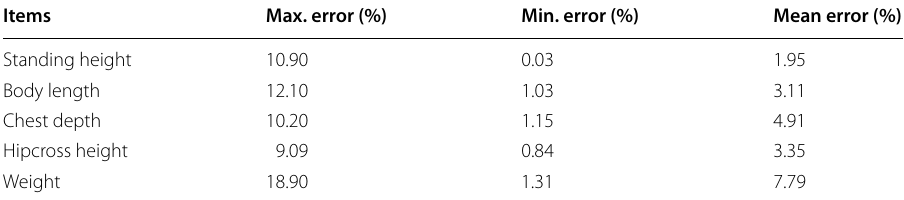
Table 8 Mean error detection results based on data of 25 yaks Items Max. error (%) Min. error (%) Standing